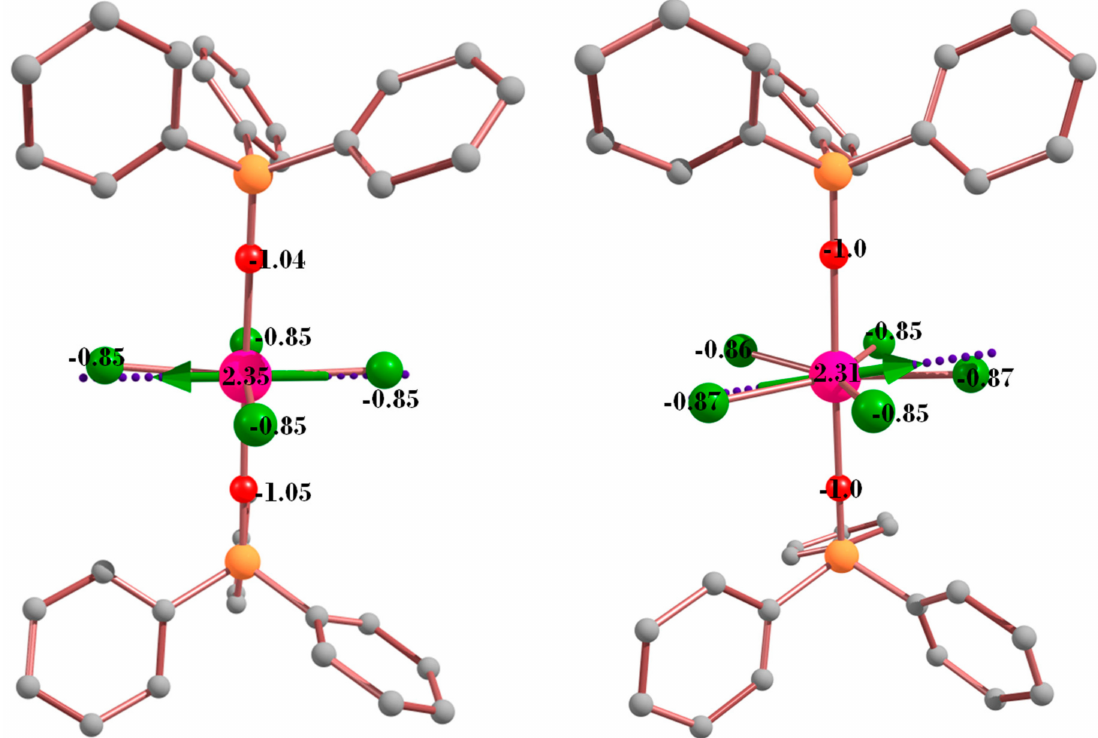
Figure 7. The structures of the model complexes ( left ) a and ( right ) b . The H atoms are omitted for clarity. Color scheme: Dy III , pink; Cl, green; O, red; C, light gray; P, orange. The dotted violet lines are the g zz directions and the green arrows are magnetic anisotropy direction of Dy III ions. The values represent the ab initio computed Loprop charge distribution on the coordinated